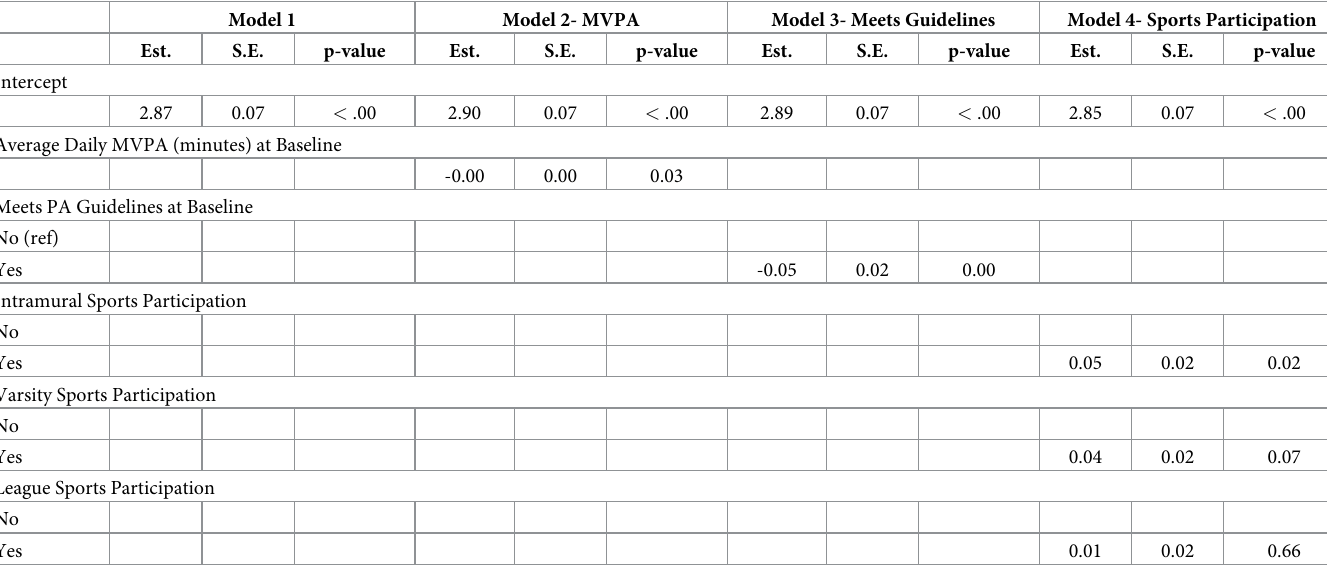
Table 2. Relationship between physical activity predictors and English grades: Ontario and Alberta, Canada